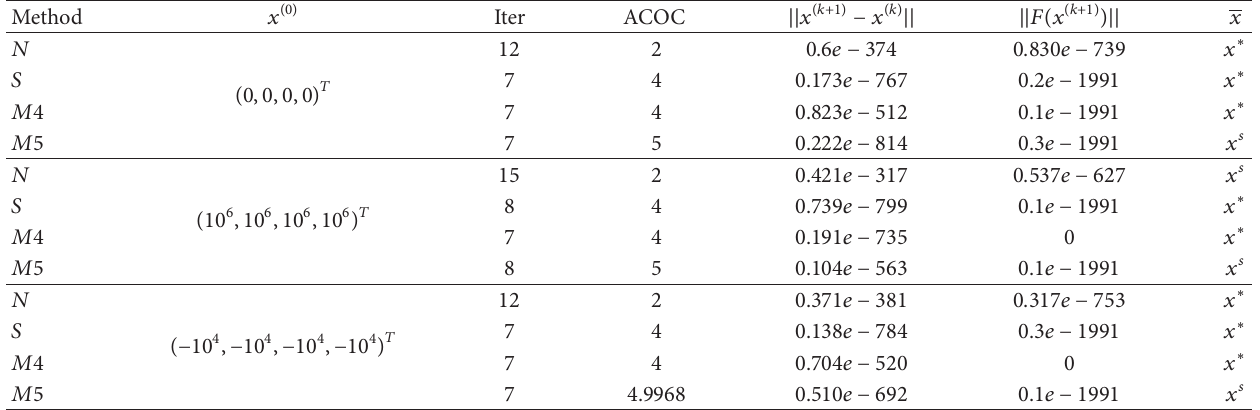
Table 2: Comparative of the iterative methods with the nonlinear system of equations of the GPS.